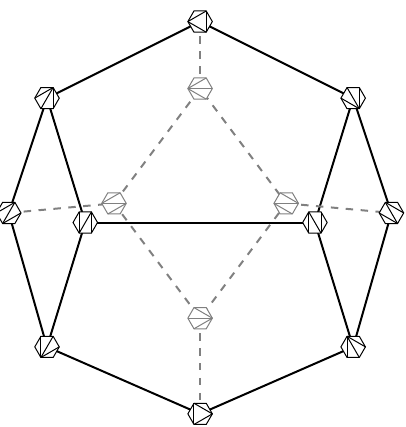
Figure 5. The Stashe(cid:11) polytope for Conf 6 ( P 3 ) (cid:24) = M 0 ; 6 with the clusters labelled by the di(cid:11)erent triangulations of a